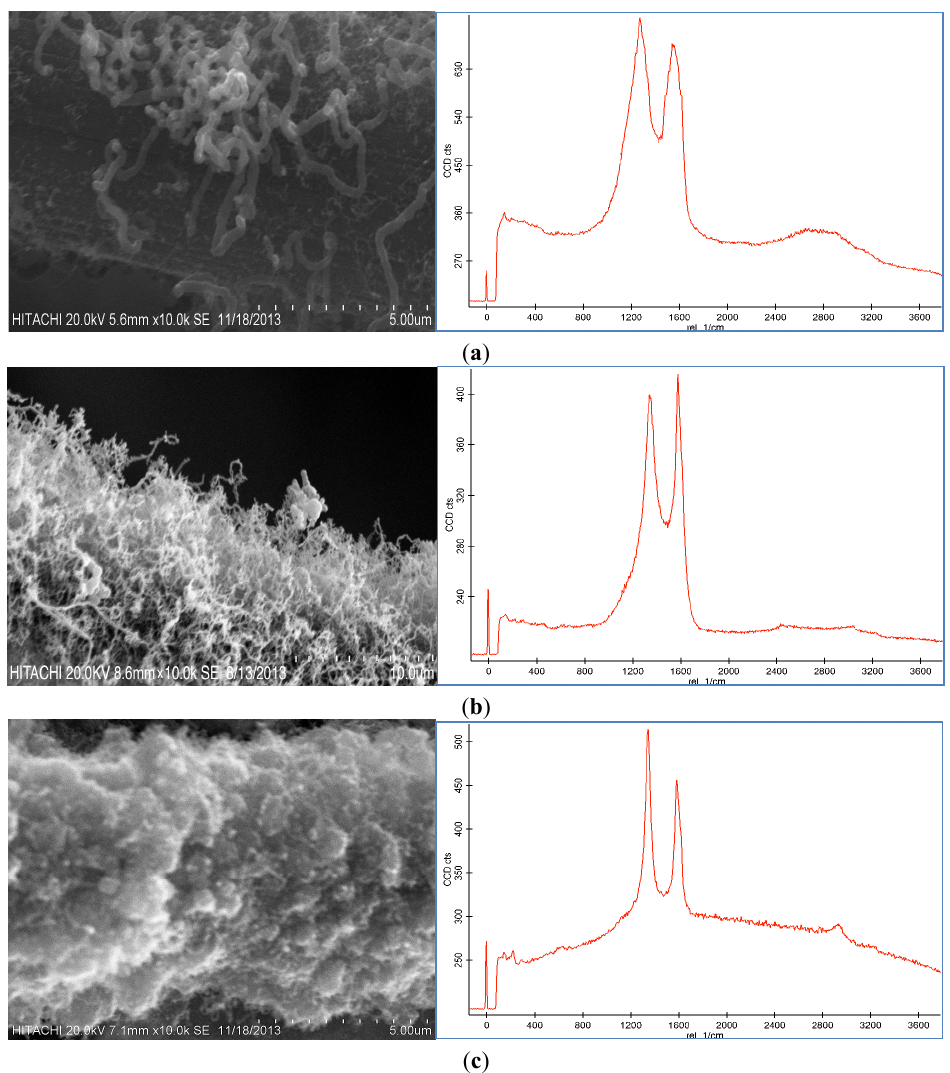
Figure 2. SEM images and Raman spectra of different agglomerations of grown carbon nanofibers (CNFs) on carbon fiber (CF) at ( a ) 50 mM, ( b ) 100 mM, and ( c ) 150 mM catalyst concentrations at 550 °C for 30 min run time under 50 sccm acetylene flow rate.